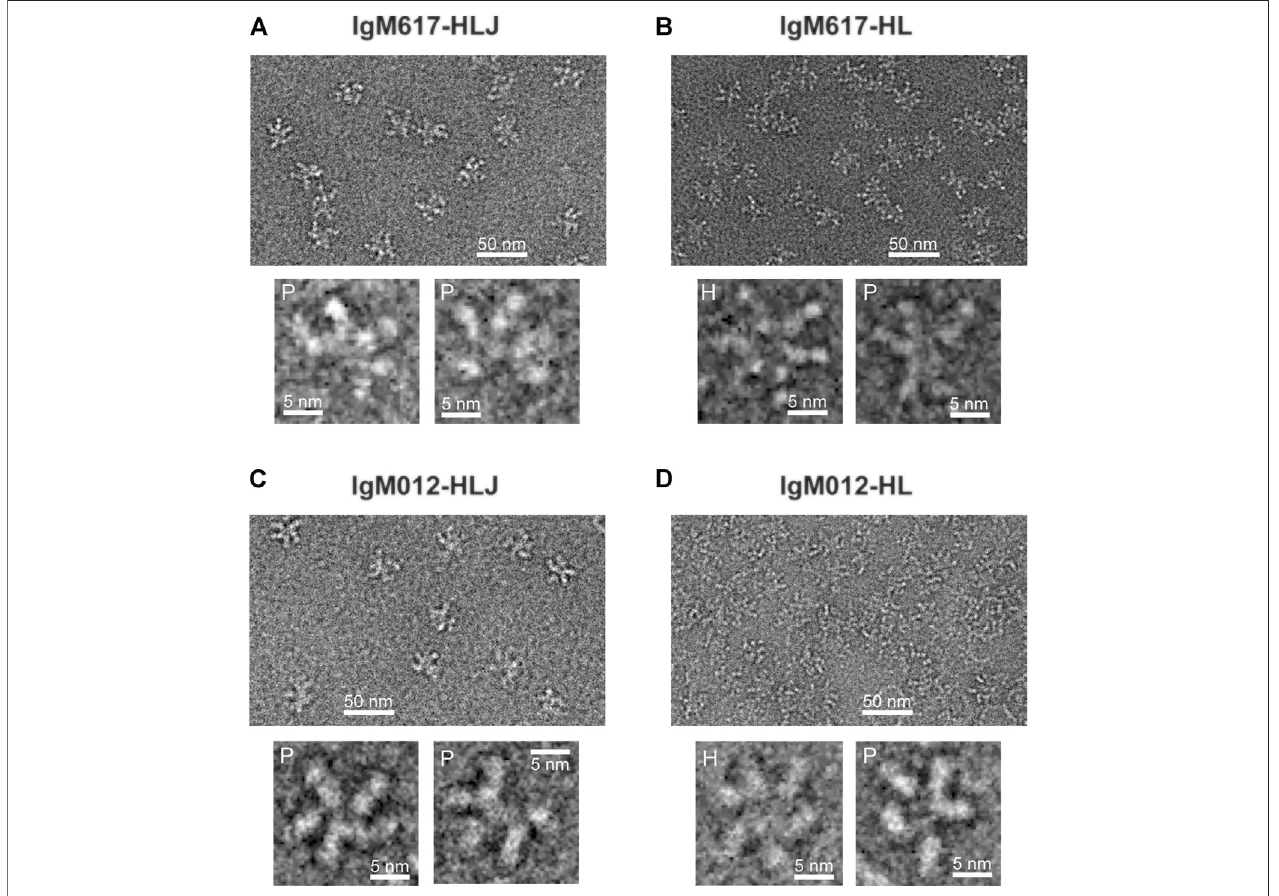
FIGURE 4 | Non-processed images of recombinant IgMs produced in HEK293F by negative stain transmission electron microscopy. Representative fi elds of particles with a 50 nm scale bar are shown on top of each panel with magni fi ed views of some individual molecules shown on the lower part of each panel: (A) IgM617- HLJ, (B) IgM617-HL, (C) IgM012-HLJ, and (D) IgM012-HL. Hexamers are denoted with H and pentamers with